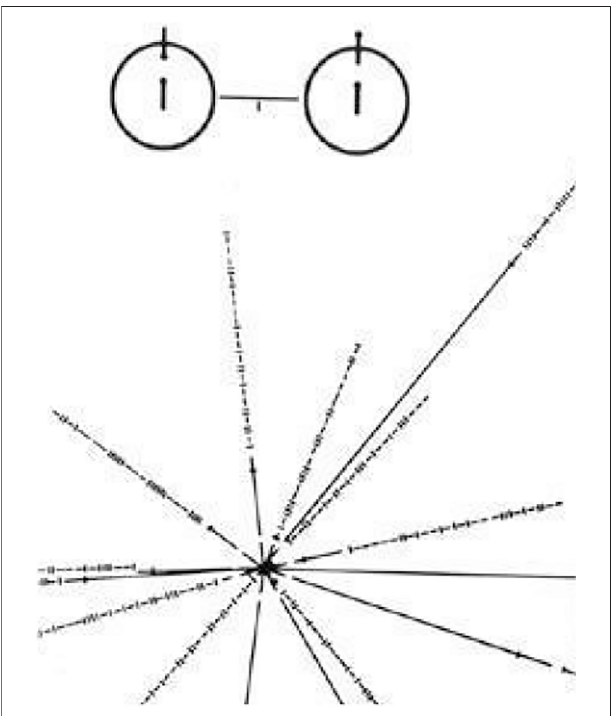
FIGURE 14 | The Pulsar Map and Hydrogen Symbol (1972 and 1973). Segment of the Pioneer plaque engraving. Credit: NASA.